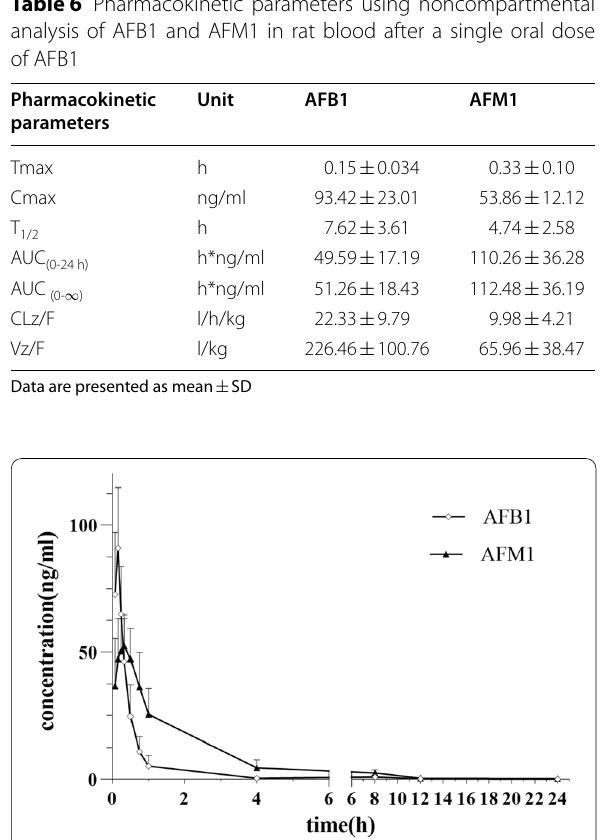
Fig. 5 Mean blood concentration–time curves for AFB1 and AFM1 following oral administration (1 mg/kg BW) in rats ( n